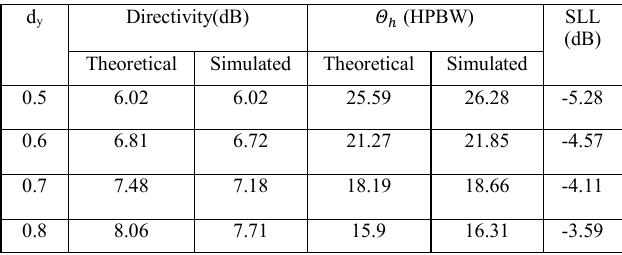
Figure 11. Planar antenna array The palnar antenna array geometry (in HFSS) is shown in Figure 12. It consists of 4 RHCP radiating elements. The inter-element spacing was kept as 0.5 (estimated using systemVue).